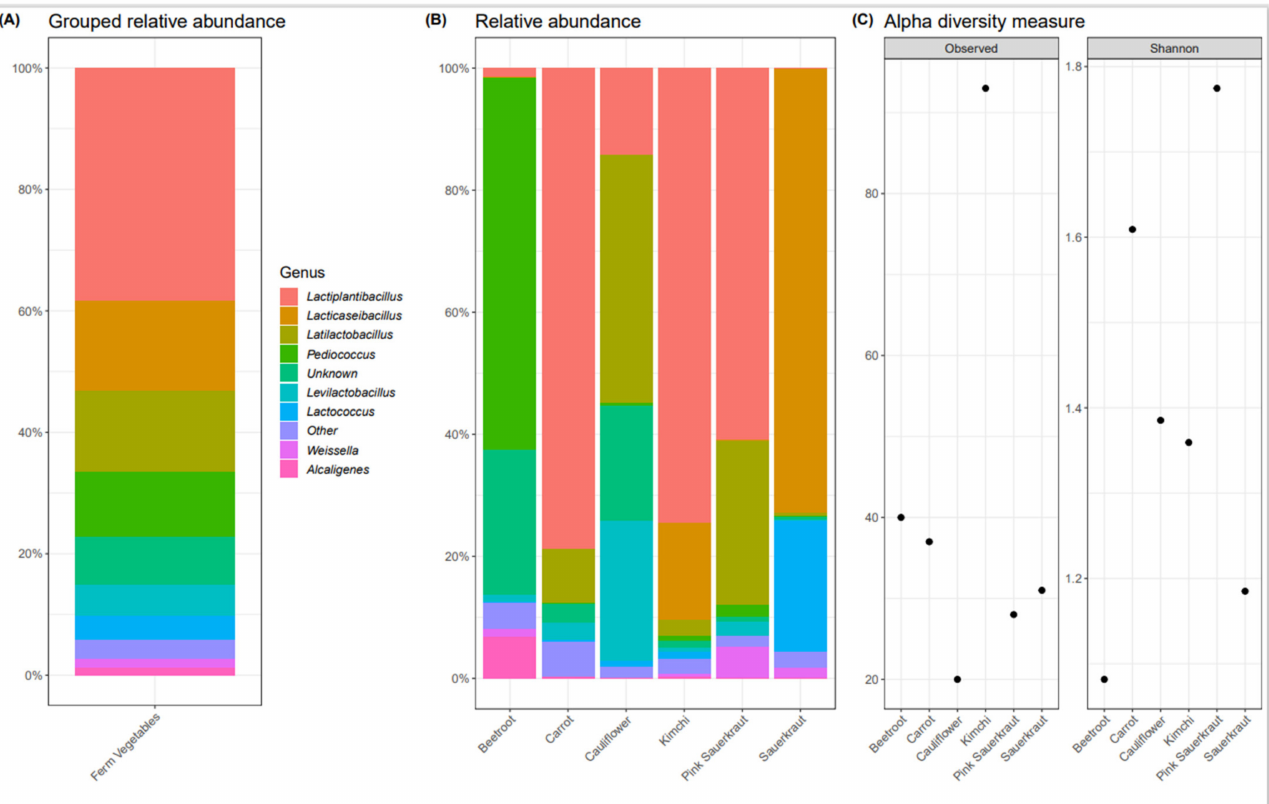
Figure 2. Bacterial composition of several commercially available fermented vegetables. Sam- ples were analyzed by 16S rRNA sequencing. ( A ) Grouped relative abundance of the fermented vegetables—the most abundant genera are displayed in the chart, genera that were abundant less than 5% in any of the samples were aggregated into one category (“Other”), and genera with no taxonomic annotation are categorized as “unknown”; ( B ) read counts (abundance) of the main bac- teria species found in the fermented vegetables; ( C ) alpha diversity of bacterial taxa found in the fermented